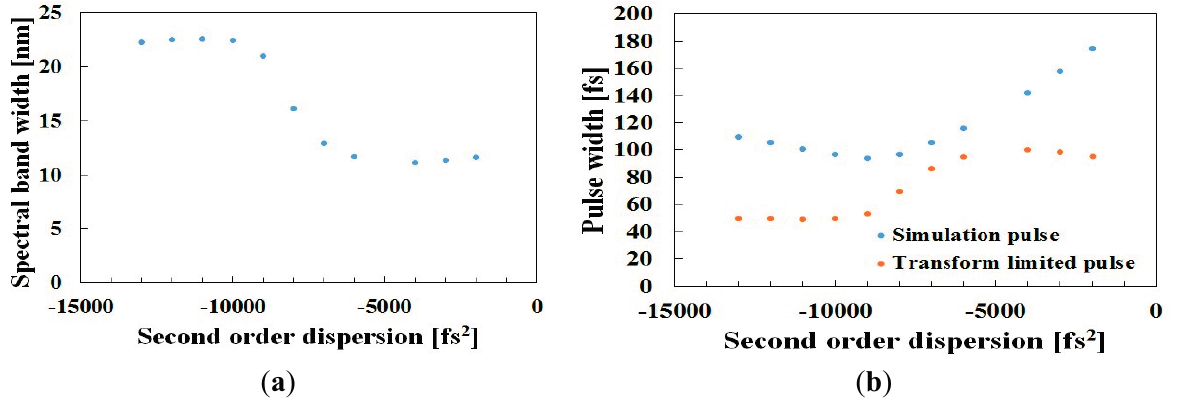
Figure 6. ( a ) The spectral bandwidth and ( b ) the output pulse width and Fourier transform-limited pulse width of the output spectrum as a function of SOD for a cavity loss of